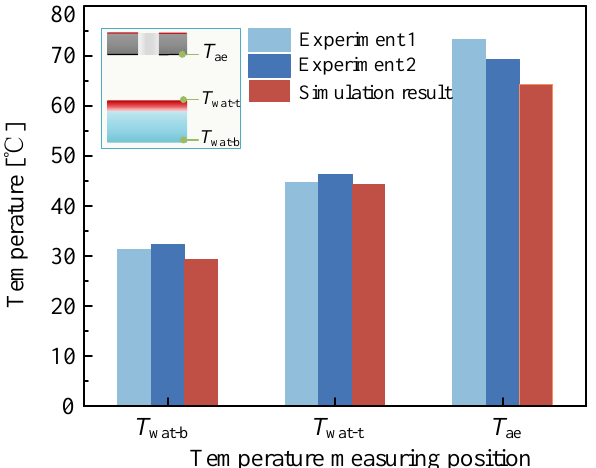
8 of 18 Figure 4. Schematic diagram of the test rig for laboratory SCE. 3. Result and Discussion With the modelling framework and experimental setup shown above, model valida- tion and simulation analysis were carried out. First, the modelling framework was vali- dated against the experiment data. Then, the comparative study of the laboratory, and the scalable SCE were completed. Second, the parametric analysis of the scalable SCE was carried out. Finally, the technical potential was explored based on the energy flow analysis of the scalable SCE. 3.1. Modelling Validation To verify the accuracy of the modelling framework, the simulation results were com-